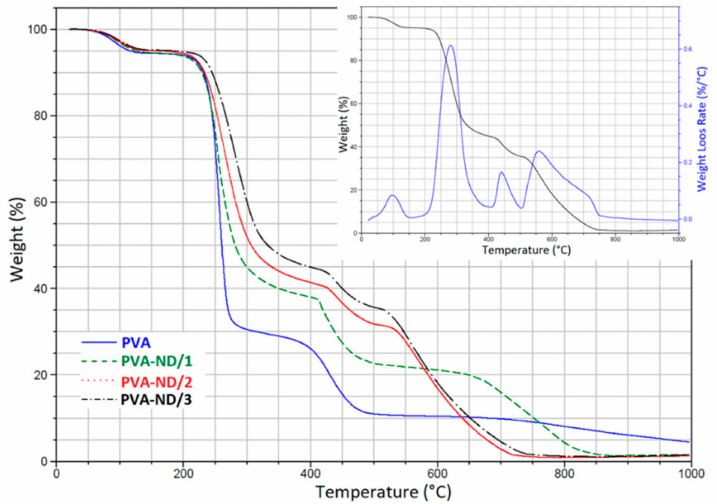
Figure 8. TGA thermograms of the pure PVA film and the PVA-ND nanocomposites; the inset graph shows the DTGA curve of the PVA-ND/3 nanocomposite (together with the original TGA